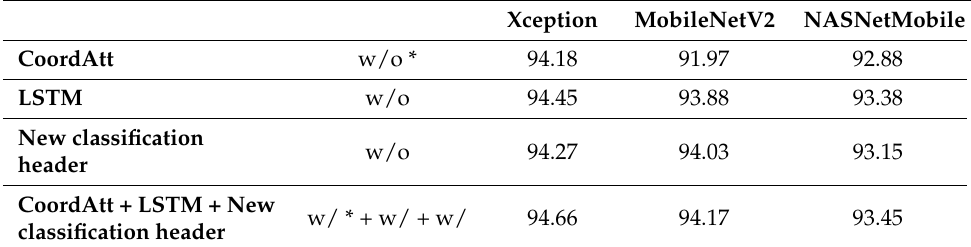
Table 4. The second set of ablation experiments, evaluation metric: Accuracy (%).